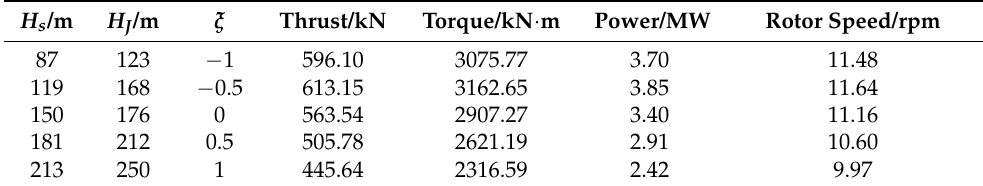
Table 8. The aerodynamic characteristics of the wind turbines at various LLJ